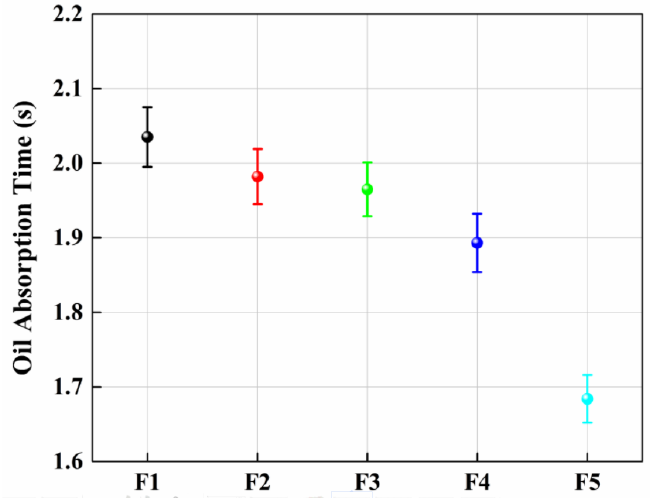
Figure 6. The absorption time of an oil drop on the different porous fibers.